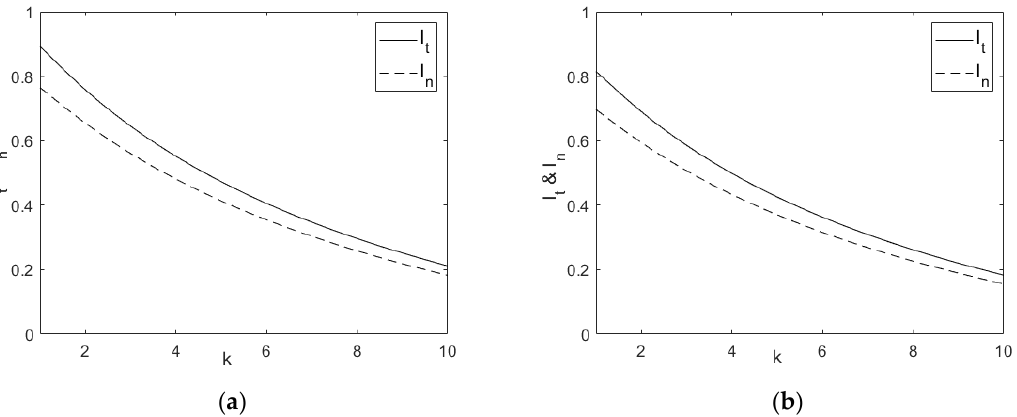
Figure 3. Impact of technology cost elasticity coefficient on the investment and production of renewable energy: ( a ) the scenario of direct sale of power; ( b ) the scenario of purchase and sale by large power grids.